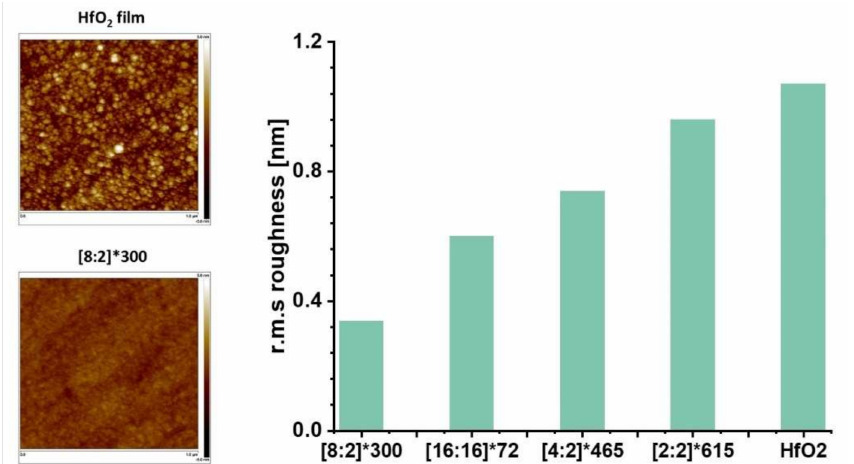
Figure 11. Surface roughness (rms) values of SiO 2 :HfO 2 heterostructures in comparison to a single- layer HfO 2 film. The corresponding AFM micrographs are included.